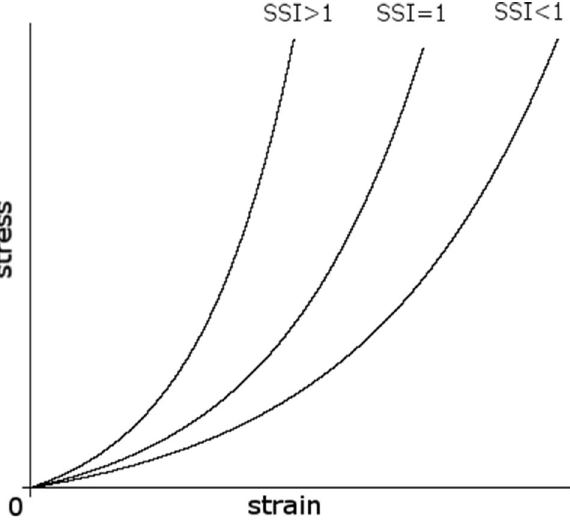
Figure 1. Stress–strain relationship and stress–strain index. Stress–strain curves for eyes with three different SSIs are illustrated. Higher SSI value indicates smaller strain (less deformation) under the same